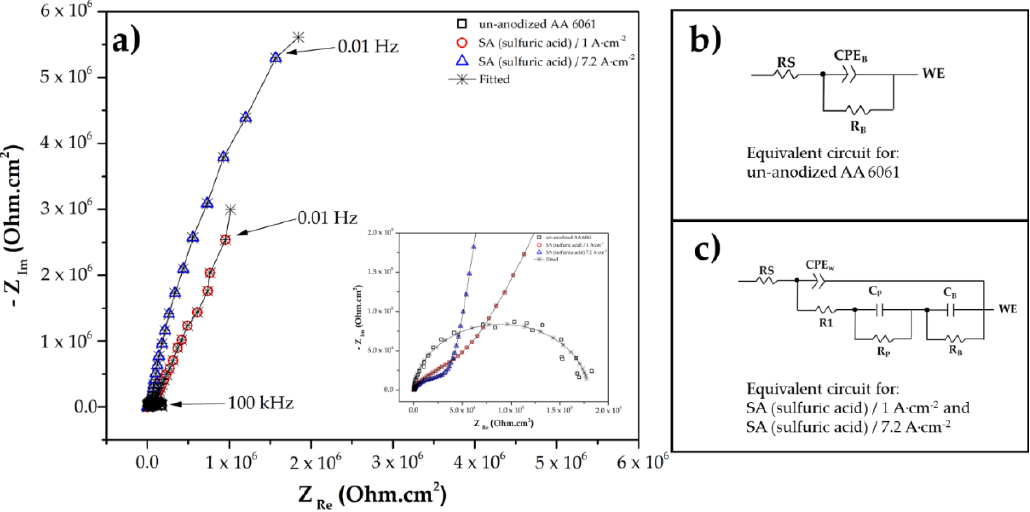
Figure 2. ( a ) Nyquist diagrams for the un-anodized AA 6061 and samples anodized in sulfuric acid evaluated in 3.5 wt.% NaCl solution; ( b , c ) equivalent circuits.